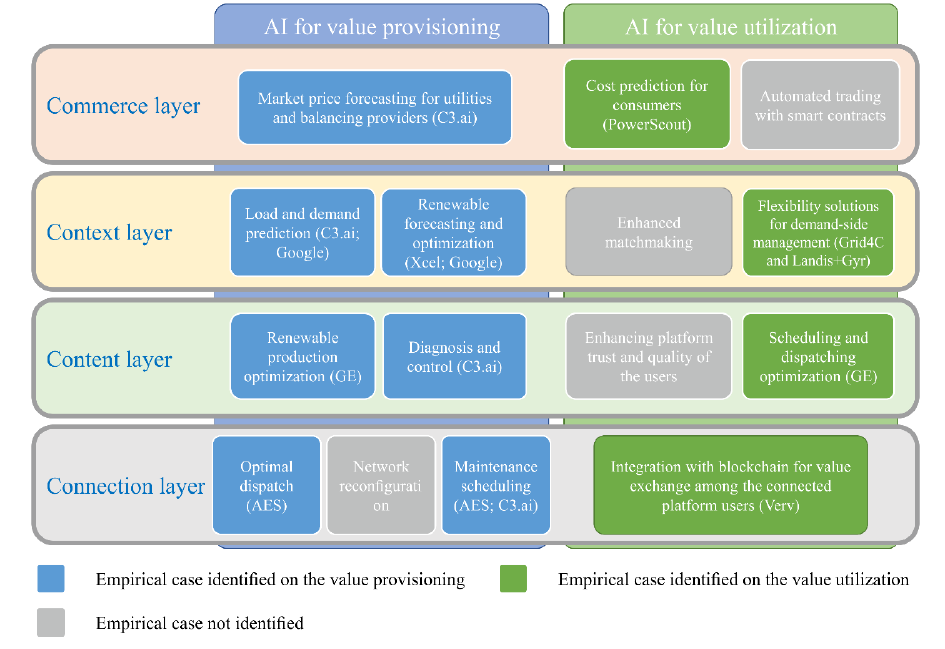
Figure 4. Validation results of the proposed platform architectural model.